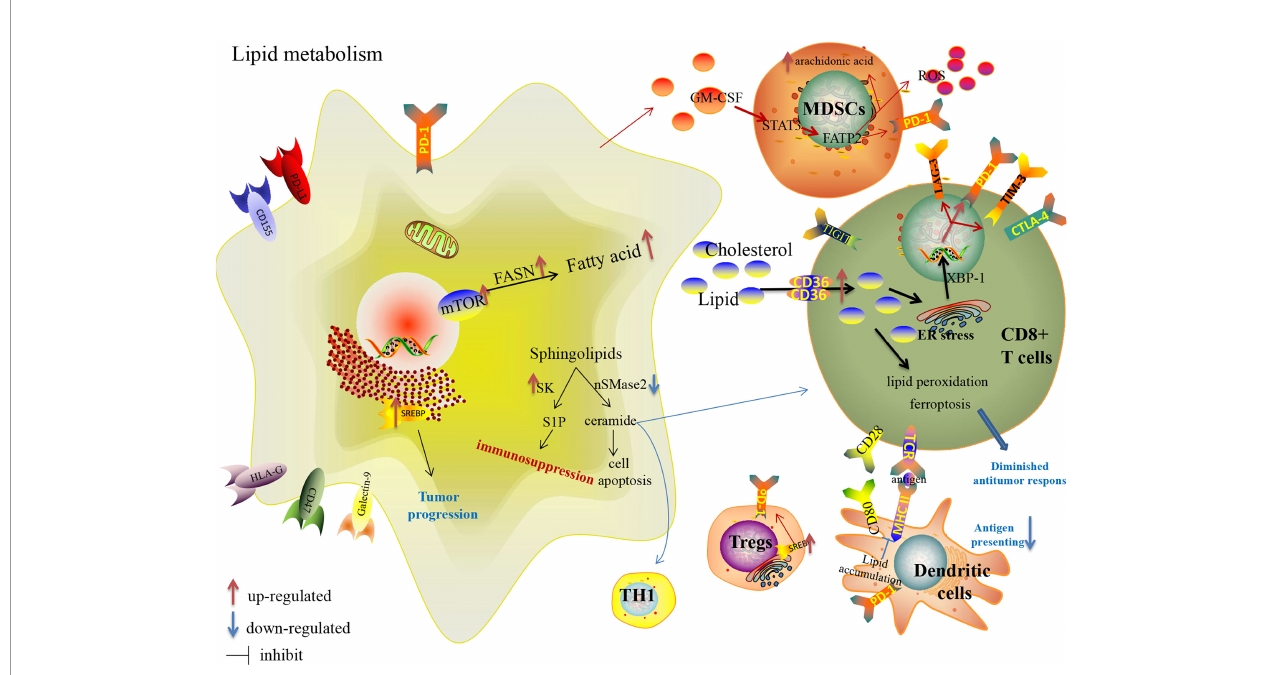
FIGURE 3 | Lipid metabolism reprogramming in cancer cells and immune cells in the TME, and their effects on the expression of immune